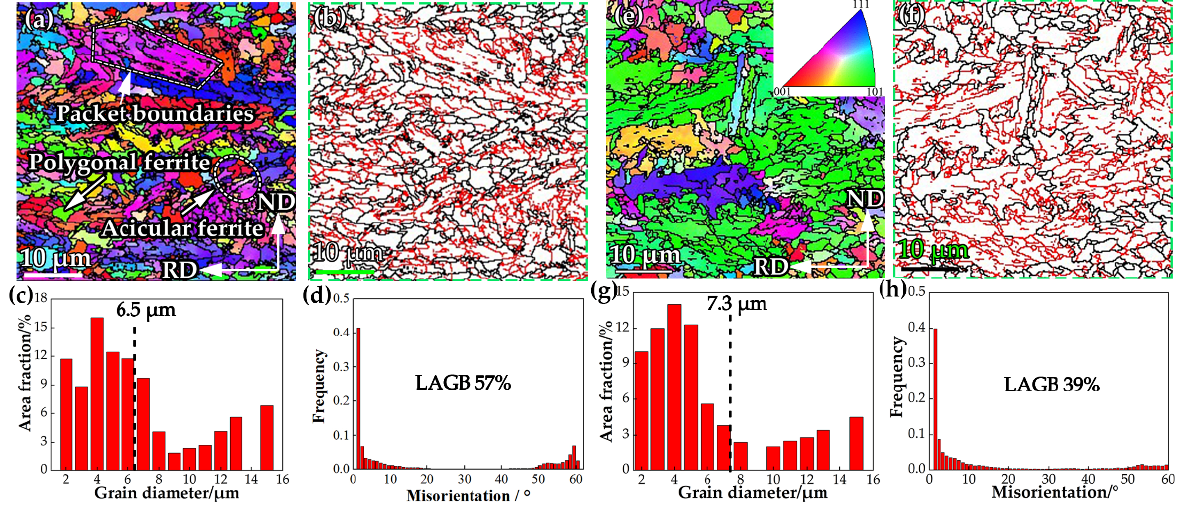
Figure 13. EBSD analysis of the specimens obtained from surface and mid-thickness region in steel A plate. ( a , e ) orientation image map, ( b , f ) image quality map with grain boundary misorientation, ( c , g ) grain diameter distribution, and ( d , h ) misorientation distribution.